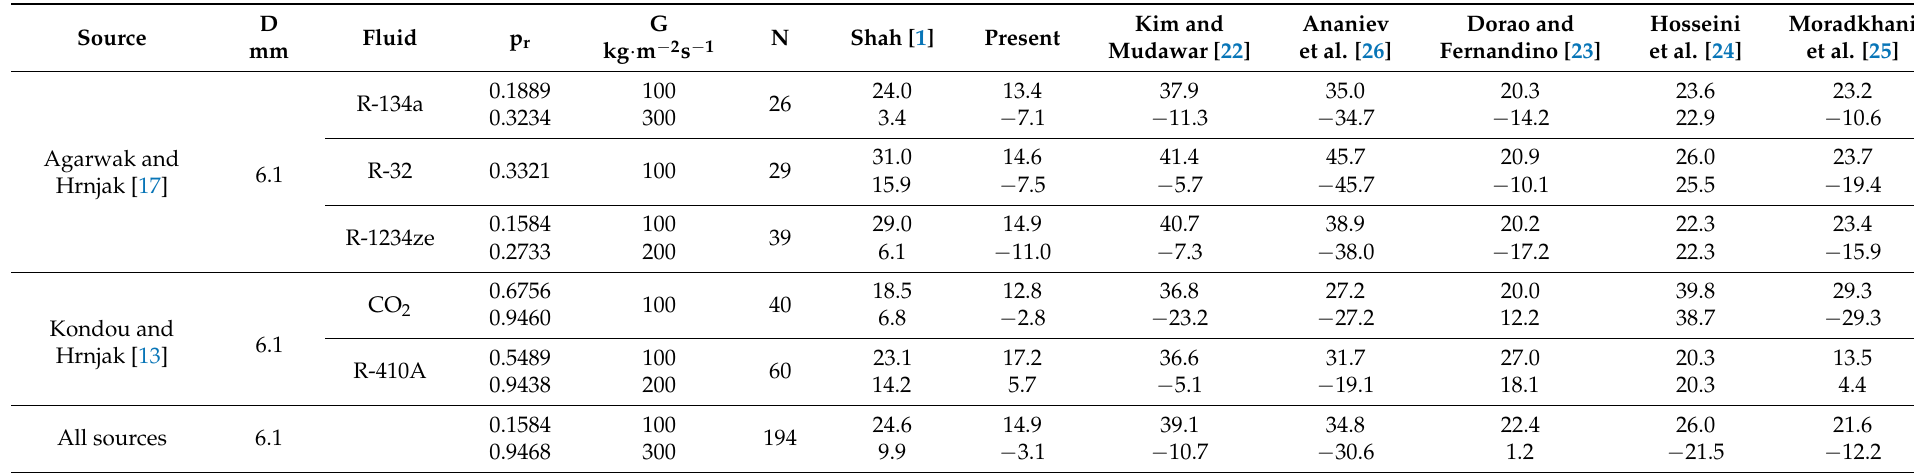
Table 2. Range of new data analyzed and deviations of various